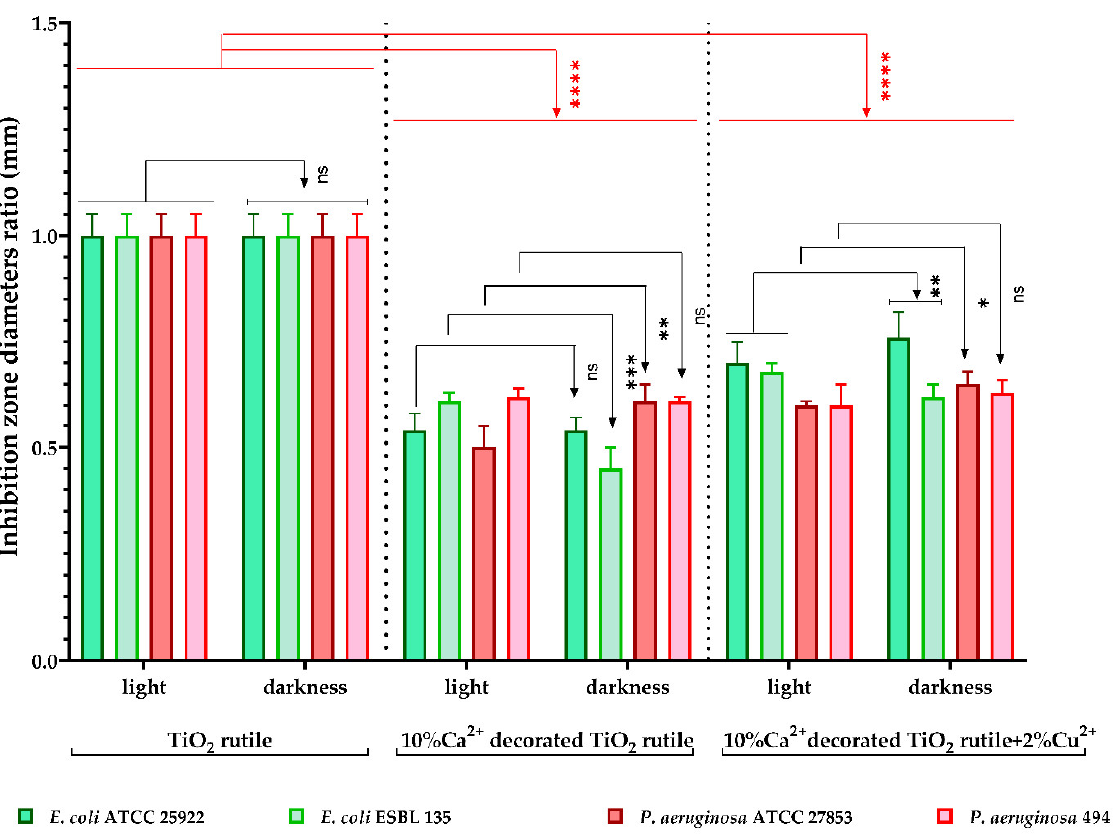
Figure 9. Graphic representation of the inhibition zone diameters, expressed as the diameter ratio, obtained for Gram-negative tested strains after incubation in two different conditions: visible light and darkness. The results were compared using two-way ANOVA and Dunnett’s multiple comparisons tests; ns—not significant; * p < 0.05; ** p < 0.009; *** p = 0.0009; **** p < 0.0001.